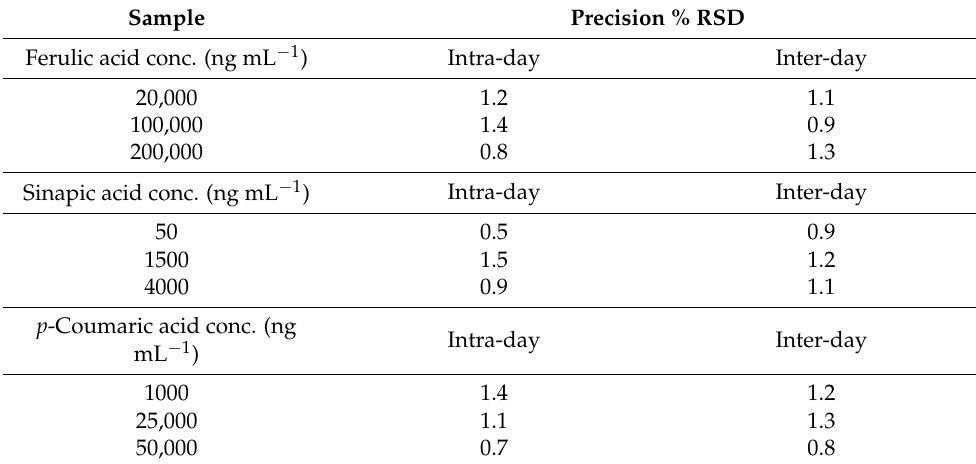
Table 2. Intra-day and inter-day assays for CeO 2 NPs SIA-CL system determination of ferulic, sinapic, and p -coumaric acids in maize kernels.